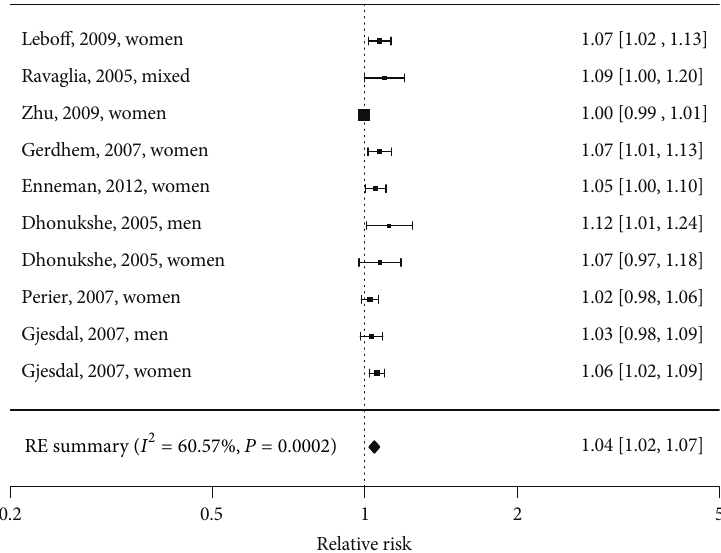
Figure 3: Forest plot of the association between homocysteine and risk of fracture: Meta-Analysis of 8 observational studies.